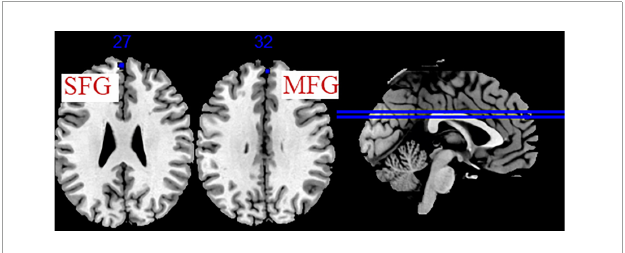
FIGURE3 Regions of brain activation in patients with pre- to post- acupuncture (immediate effect). Blue represents brain deactivation regions.